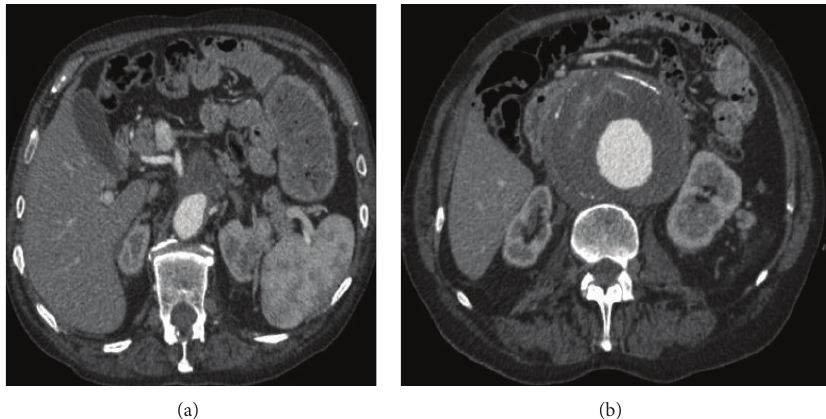
Figure 1: Preoperative CTA showing the extension of the AAA to the juxtarenal tract of the abdominal aorta (a) and the maximum diameter of the aneurysm (b). No signs of hydronephrosis were noted preoperatively.